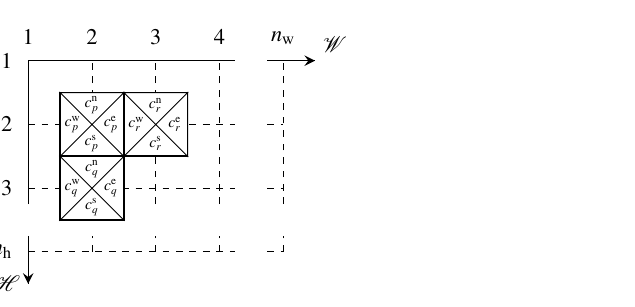
Figure 3. Color matching among tiles p , q , and r ∈ T